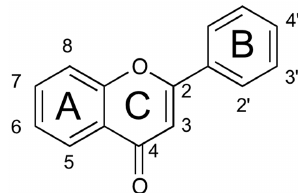
Figure 1. Structure of the 2-phenyl-1,4-benzopyrone.